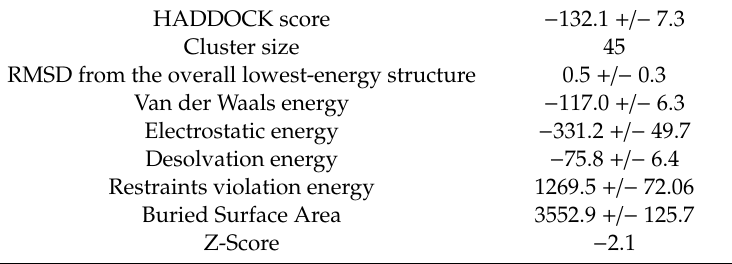
Table 6. Protein–protein docking results of the vaccine construct and TLR7. HADDOCK score − 132.1 +/ − 7.3 RMSD from the overall lowest-energy